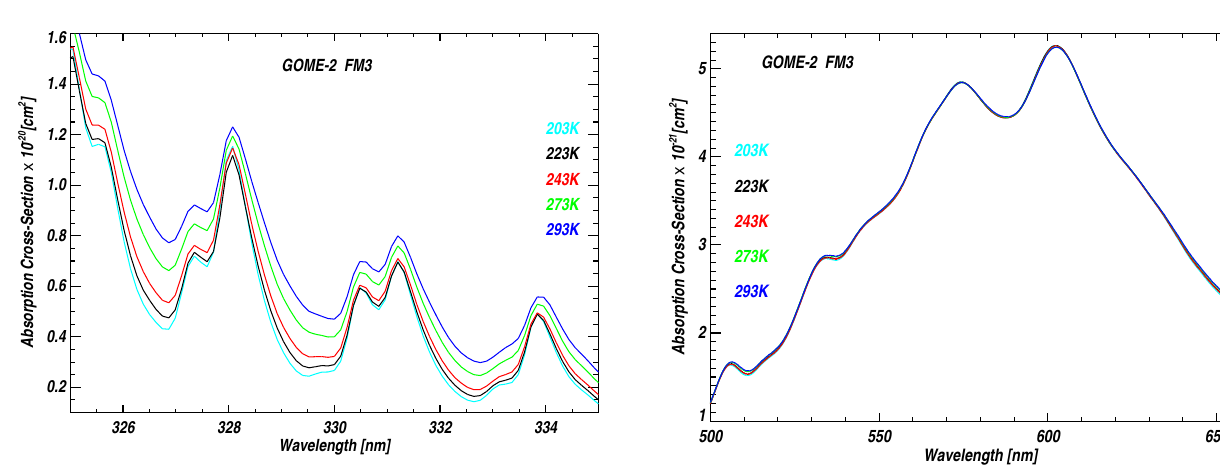
Fig. 4. GOME-2 FM3 temperature dependent absorption cross sec- tion spectra in the Chappuis